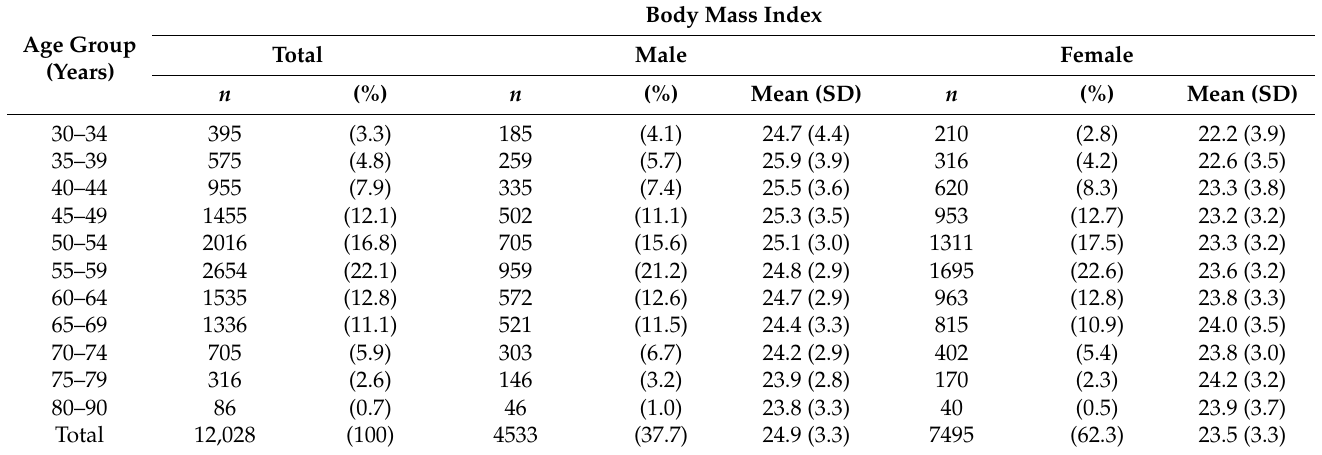
Table 1. Age-specific body mass index for Taiwanese men and women.